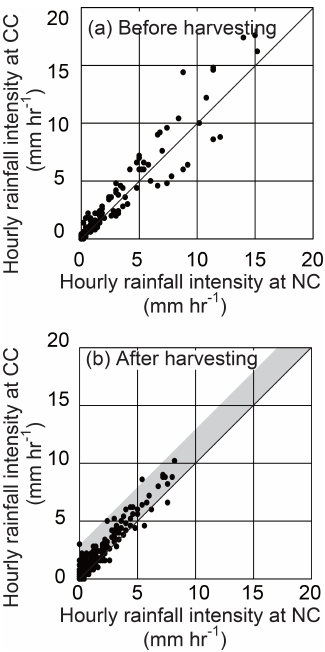
Figure 8. Comparison of the hourly rainfall intensity between sites NC and CC. (a) Comparison before forest harvesting (25 August to 2 September and 4 November to 30 November 2012). The rainfall monitoring was disrupted by damage to the rain gauge associated with a typhoon (2 September to 7 October) and by a malfunction of the data logger (7 October to 3 November). (b) Comparison after forest harvesting (4 April to 3 July 2012). The range where rainfall intensity at CC is 0 to 3mmh − 1 higher than at NC is